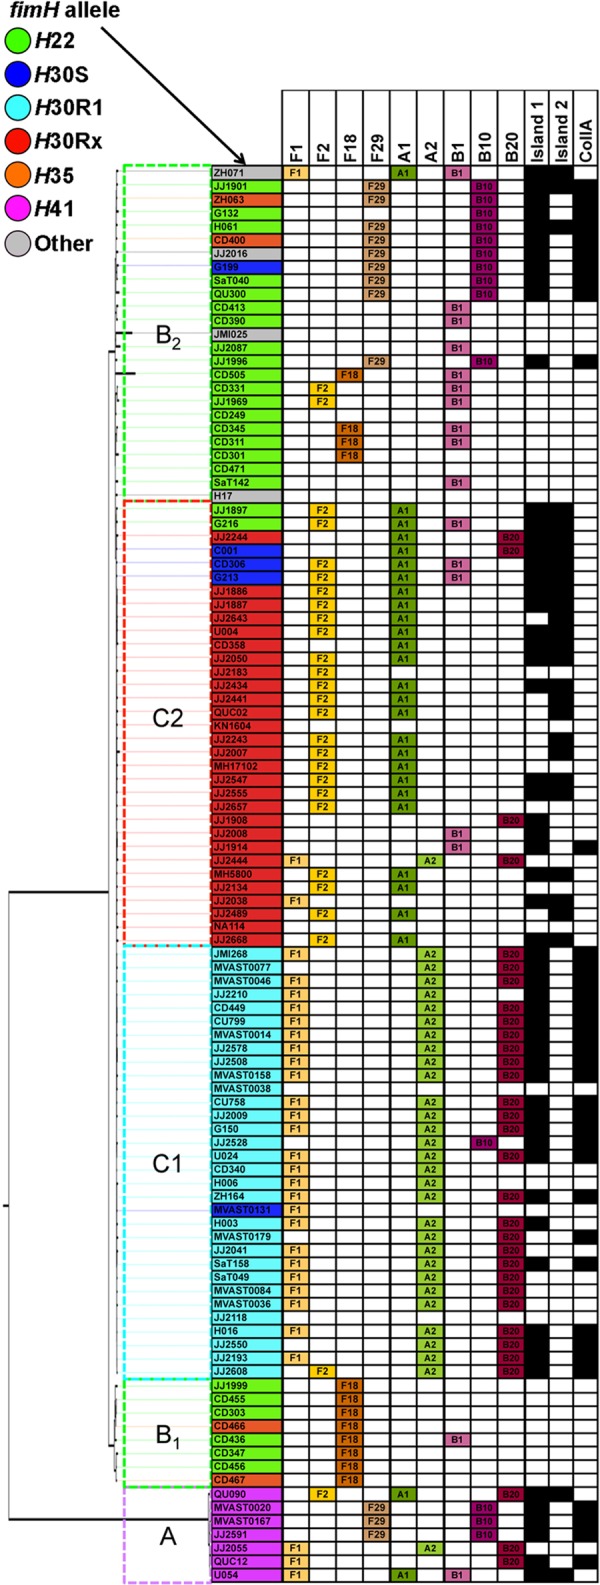
Distribution of F plasmid allele types, island 1, island 2, and the ColIa-containing island among ST131 strains. Strains are ordered by their position in the ST131 phylogenetic tree adapted from reference 5 and colored by fimH allele type according to the figure legend. Strain clades (A, B1, B2, C1, and C2) are designated by colored and labeled dashed boxes. Under island 1, island 2, or ColIa, a black-shaded box indicates >99% nucleotide similarity across >90% of the sequence queried.